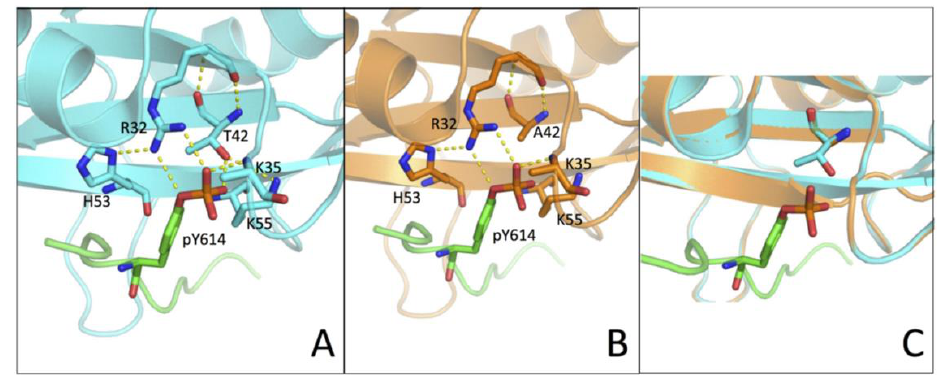
Figure 4. ( A , B ) Three-dimensional structure of the N-SH2 domain wt (in cyan) and T42A (in orange) in complex with Gab1 (in green) (PDB: 4QSY). Residues R32, K35, T42/A42, H53, and K55 are highlighted with sticks and H-bonds are represented by yellow broken lines. ( C ) Homology modelling of the T42A variant of the N-SH2 domain (in orange) computed with SWISS-MODEL web-based service, using PDB 4QSY as template structure (in cyan). Side-chains of T42/A42 are highlighted with sticks.